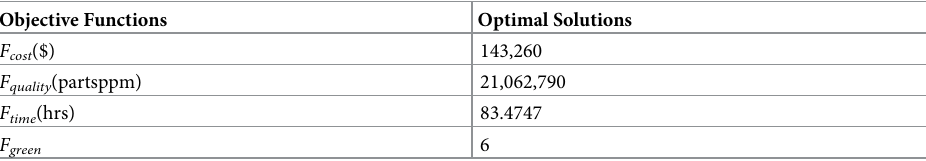
Table 11. Optimal solutions of objective